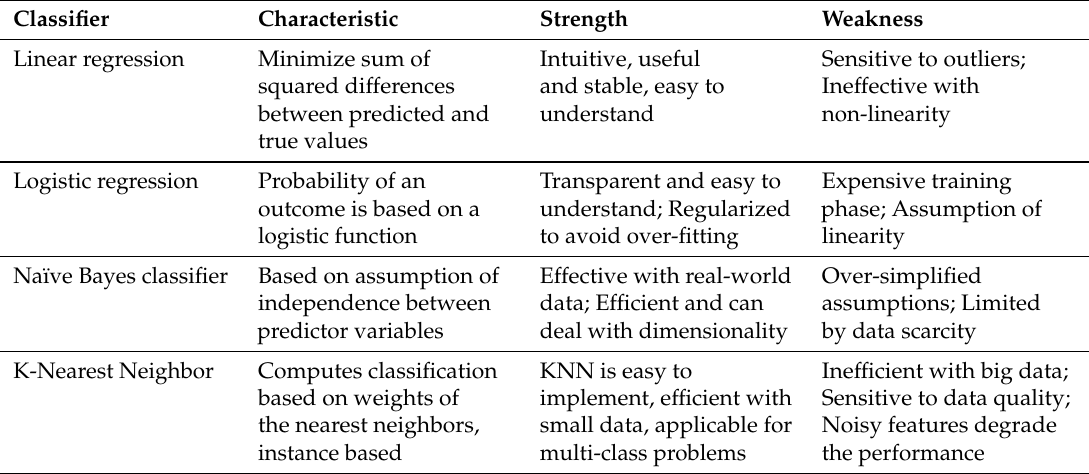
Table 4. Summary of classifiers for machine